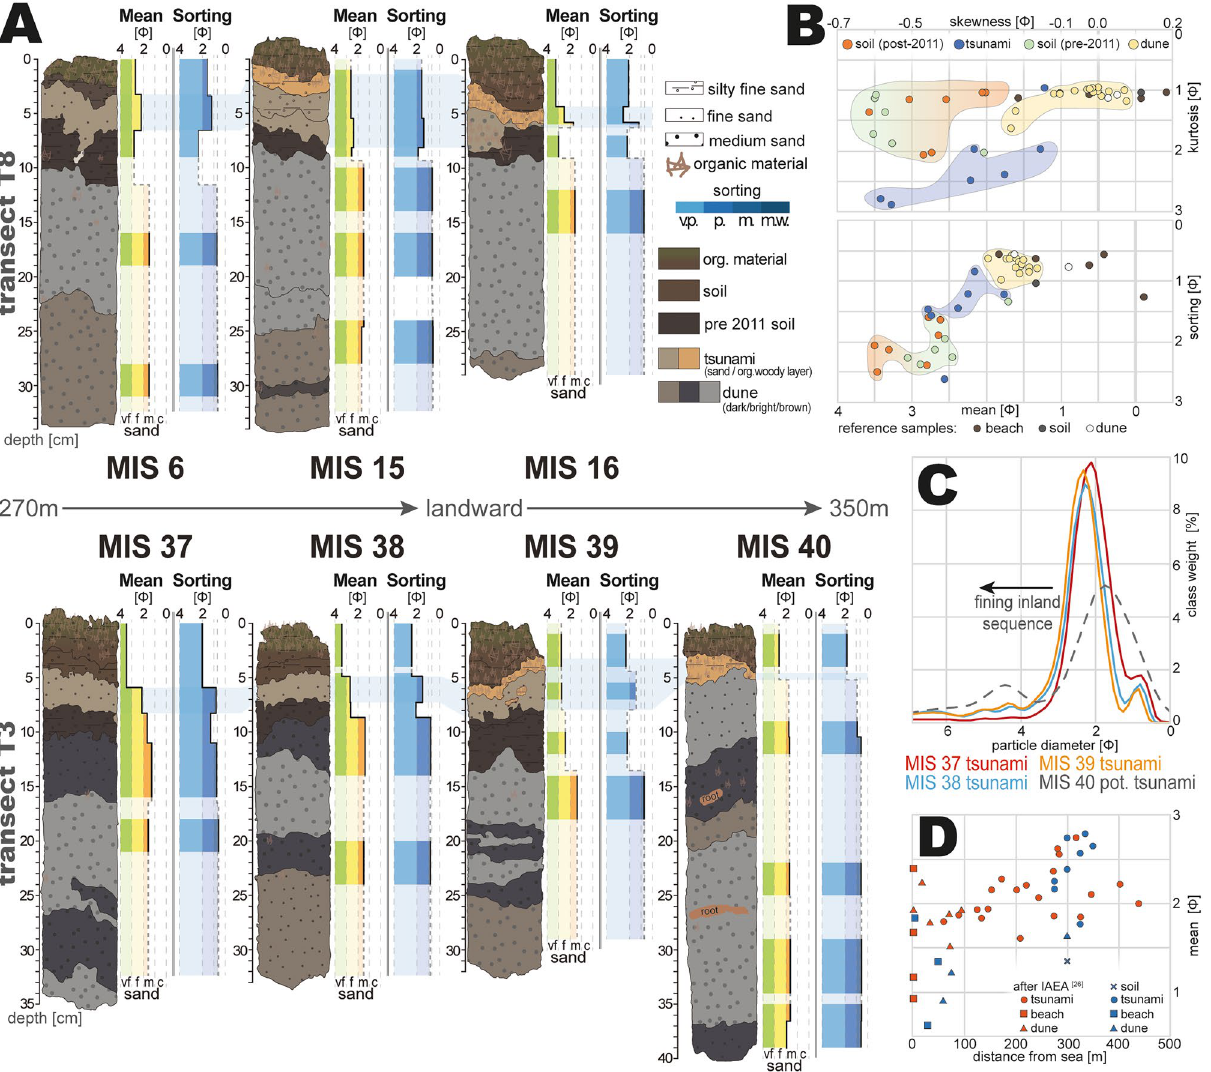
Figure 4. ( A ) Grain size distribution and sorting (Φ) in transects T3 and T8; ( B ) Bivariate plots of skewness against kurtosis and mean grain size against sorting (all in Φ) for all samples. Areas show grouping of soil, dune and tsunami samples; ( C ) Representation of the tsunami layer’s fining inland sequence in transect T3; ( D ) relationship between the distance from the shoreline and mean grain size of tsunami deposits and reference samples 26 . Orange symbols represent data from 4 transects at Misawa 26 and blue symbols represent data from transect T3 and T8. Shown data has been plotted using Microsoft Excel 365 (https:// office. micro soft. com/ excel) and illustrated Adobe Illustrator (Creative Cloud version 2020, https:// adobe. com/ produ cts/ illus samples. In MIS 6 the highest amounts of short- and long-chained n -alkanes are in the topsoil, while in MIS 15 the highest amounts of short- and long-chained n -alkanes are in the dune samples. Here the 2011 tsunami layer is likely comprised of a mixture of sediment sources from the nearshore, beach and the eroded forest floor itself. Further inland at MIS 16, the tsunami sand layer stands out by representing the highest concentration of short- chained and long-chained terrestrial n -alkanes within this stratigraphic profile. On the contrary, the woody and organic layer of MIS 16 separates itself by the lowest amounts of both short- and long-chained n -alkanes. In MIS 17 with the floating plastic particle the tsunami layer represents slightly lower concentrations from the over- and underlying soil. The sediment profiles located closest to the coast of transects T3 and T8 contrast each other significantly in the contribution of short-chained n -alkanes within their 2011 tsunami layer. In profiles MIS 37 to MIS 38 the tsunami layer has the significantly highest short-chained n -alkane concentration, only in MIS 40 where the sand deposit disappeared no strong indication of short-chained n -alkanes is visible. The terrigenous/aquatic ratio (TAR), an indicator to determine relative amounts of terrestrial versus aquatic n -alkanes in a sediment 30 , responds in relation to the total long-chained and short-chained n -alkane concentration. In most tsunami samples across both transects, the TAR can be used to differentiate the tsunami layer from the surrounding terrestrial sediments through a lower terrestrial and increased marine signal.